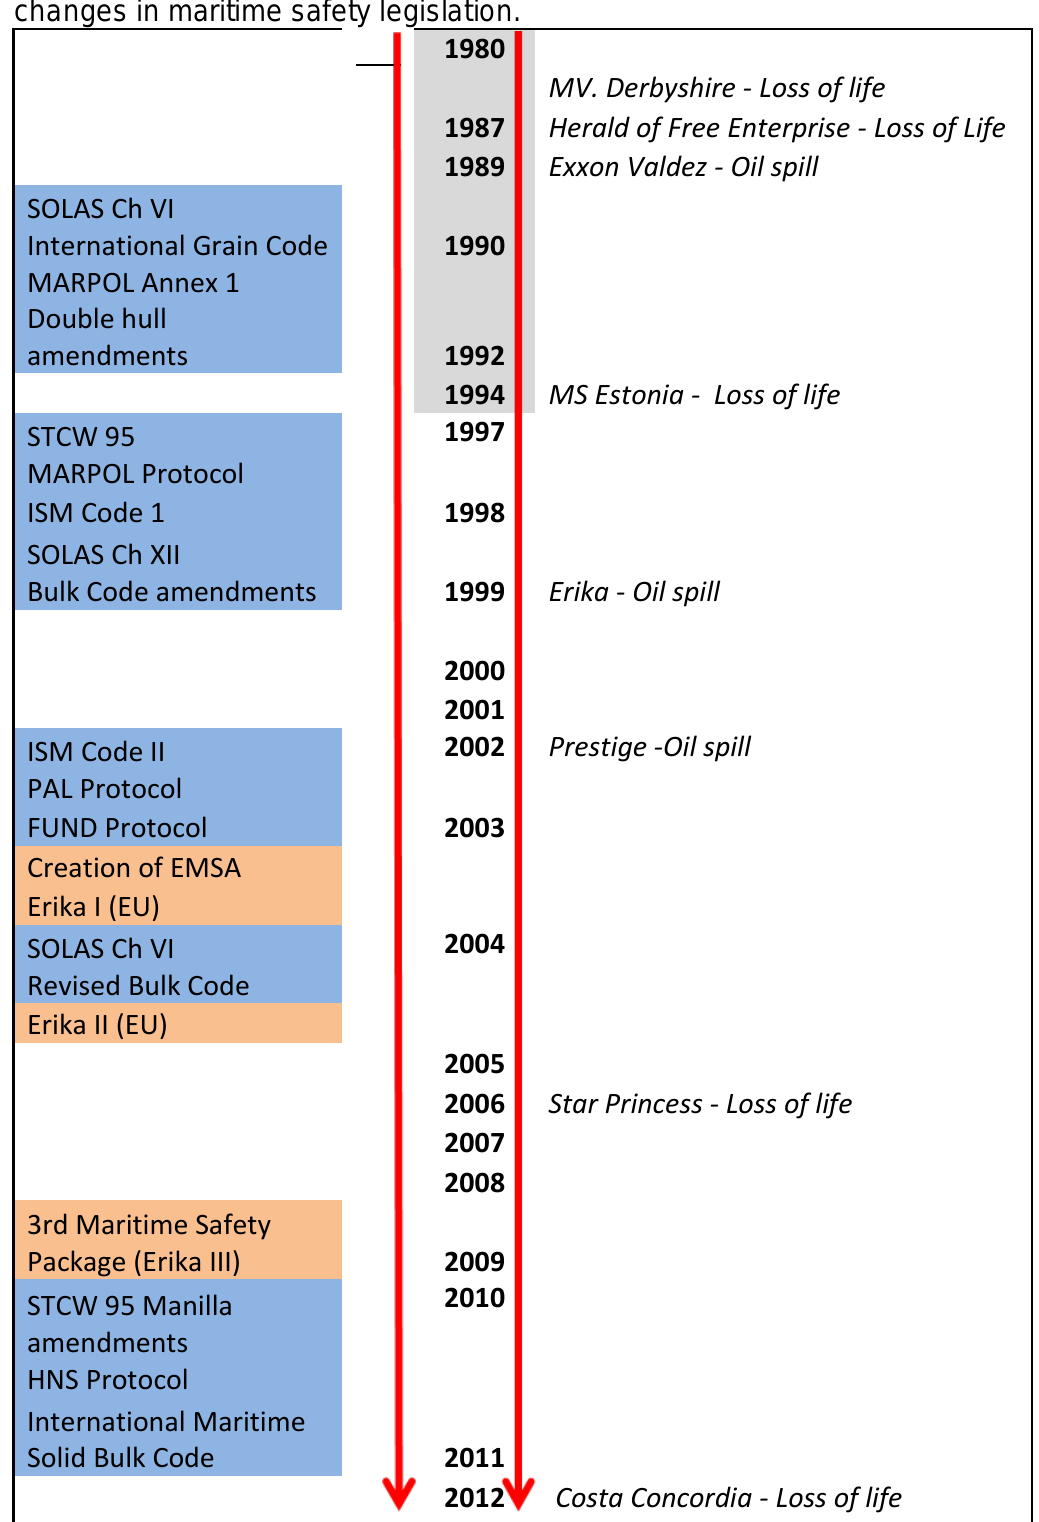
Figure 1: The 15 year time line and key shipping accidents and subsequent changes in maritime safety